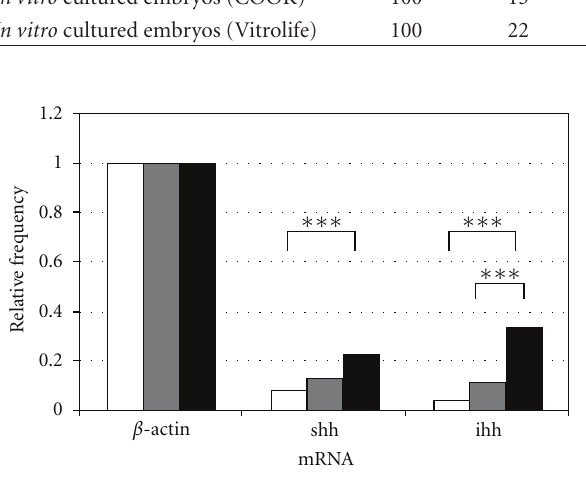
Figure 2: Quantitative analysis of mRNA expression of shh, and ihh of single murine blastocyst either cultured in vivo (white) or in vitro in COOK’s Cleavage medium (grey) or in Vitrolife’s G-1 PLUS medium (black) compared to β -actin as housekeeping gene with ∗ P < 0 . 05; ∗∗ P < 0 . 02; ∗∗∗ P < 0 . 01. murine blastocysts of the COOK and 72 of 78 (92%) murine blastocysts of the Vitrolife medium group expressed gpx1 mRNA.